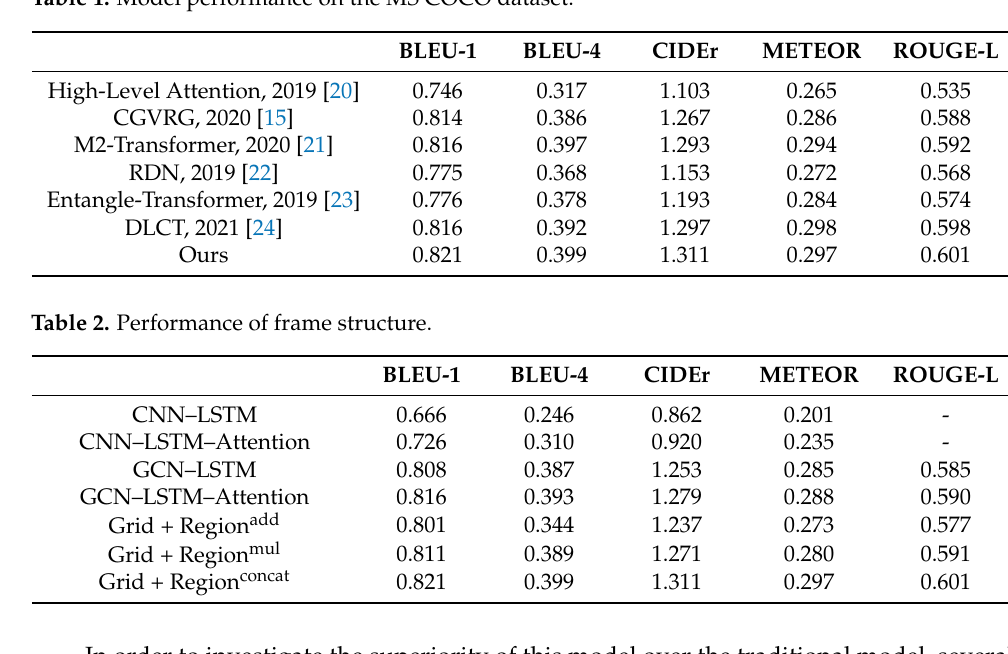
Table 1. Model performance on the MS COCO dataset.